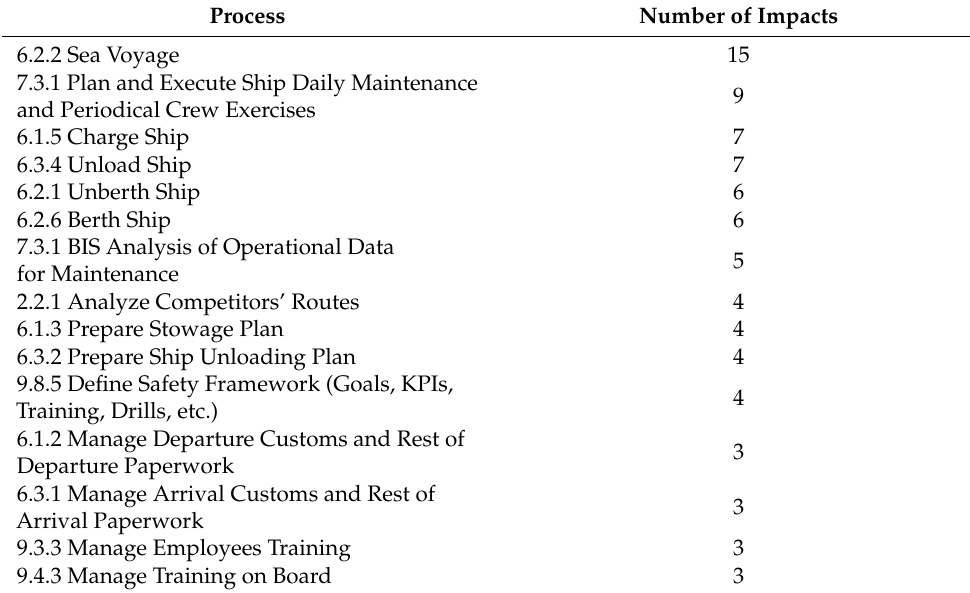
Table 2. Processes with more than two